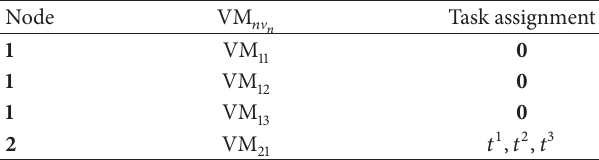
Table 7: High slowdown. Solver assignment.